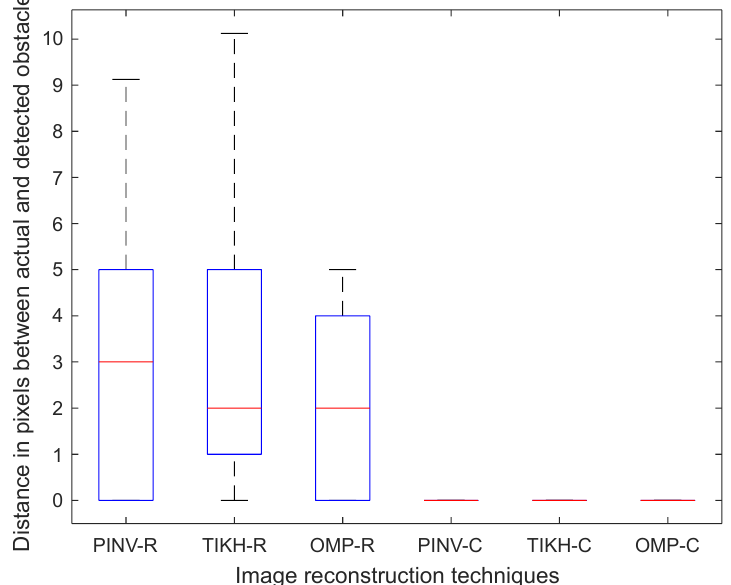
Figure 17. Euclidean distance in pixels between the single reconstructed obstacle coordinates and its actual coordinates in the ground-truth.